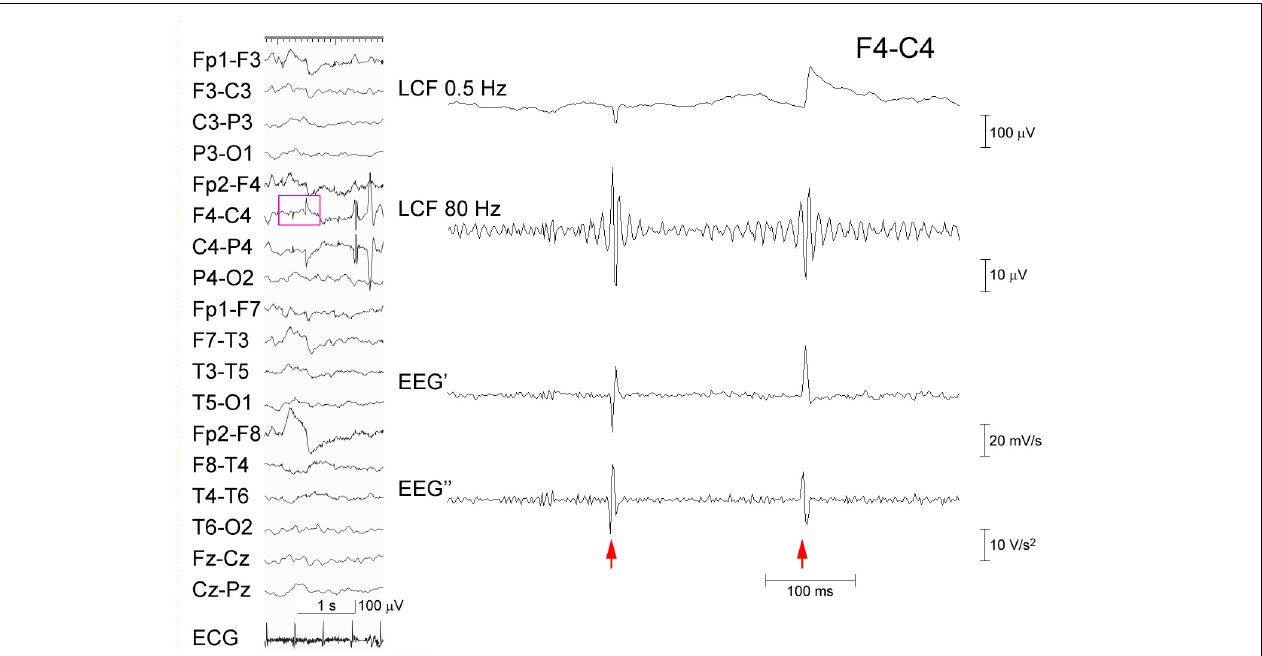
FIGURE 1 | Processing of EEG artifacts. Two artifacts that were caused by poor electrode contact at C4 (left panel). The EEG data at F4–C4 (pink rectangle) that were recorded from a 5-year-old boy is temporally expanded (right panel) (abrupt potential jumps at arrows). From the top: EEG processed with an FIR low-cut frequency (LCF) filter at 0.5 Hz; EEG LCF filtered at 80 Hz showing spurious oscillations; EEG’; and EEG (cid:48)(cid:48) showing no ringing. The corresponding time–frequency analysis is shown in Supplementary Figure 1A .